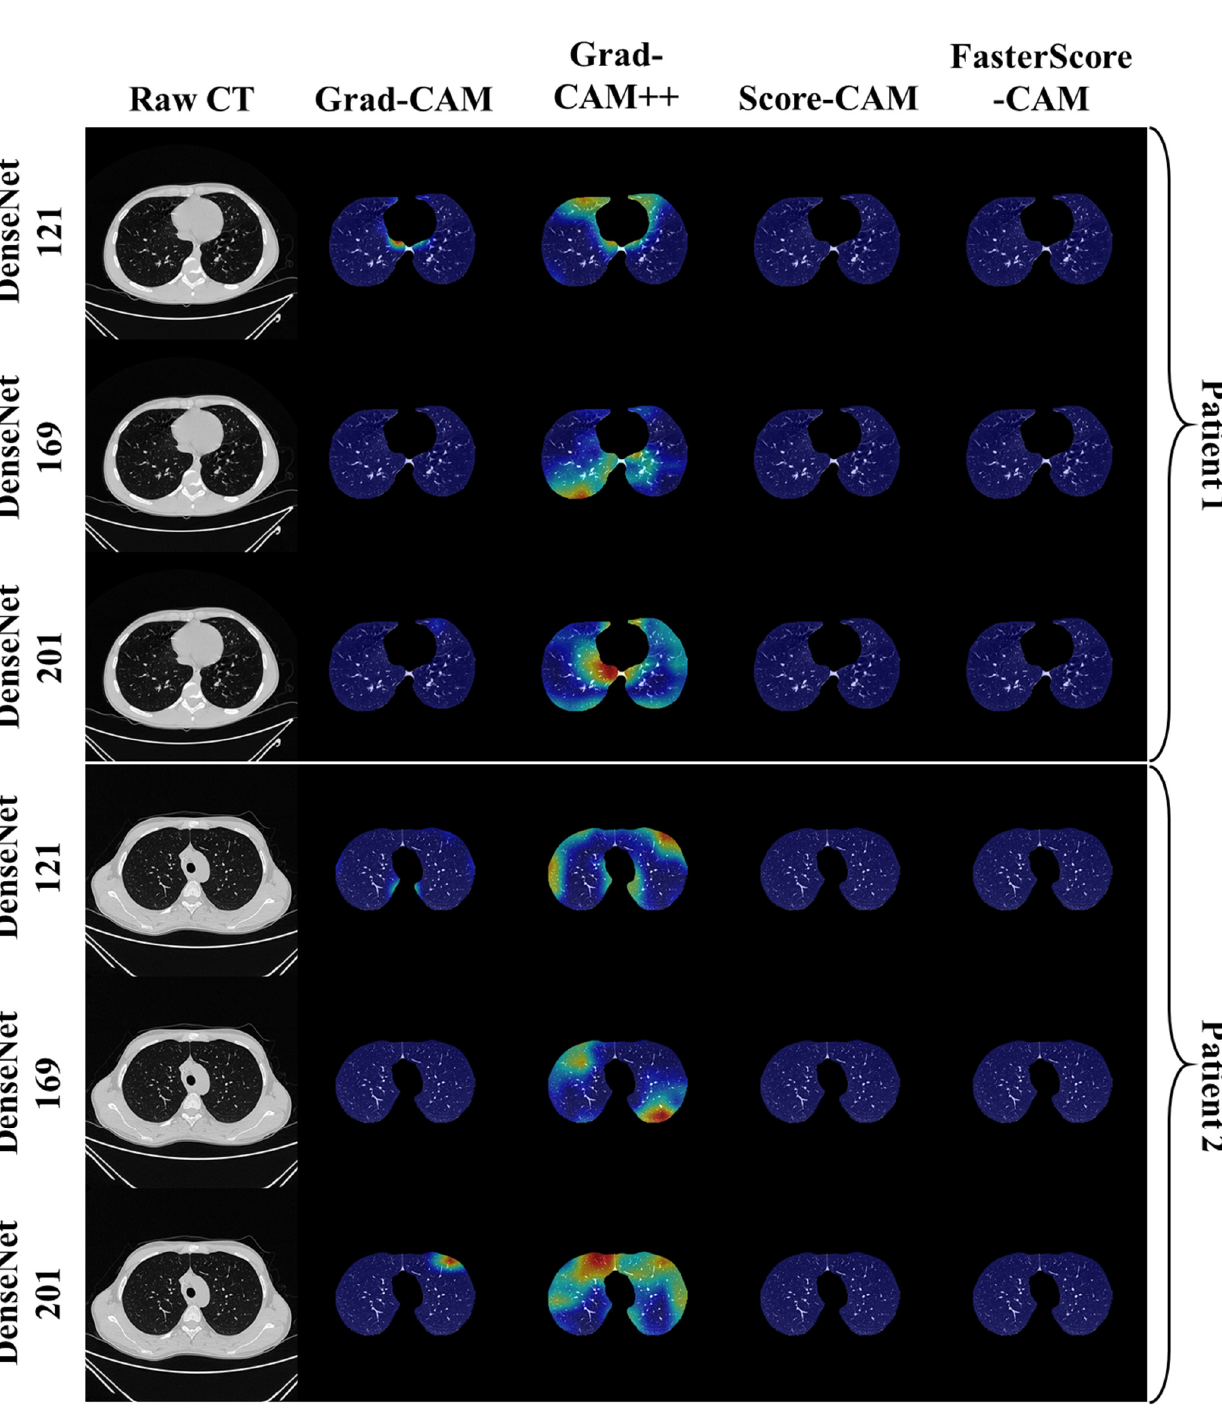
Figure 13. Heatmap using four CAM techniques using three kinds of DenseNet classifiers on control images. The top row is the CT slice for patient 1, and the bottom row is the CT slice for patient 2.